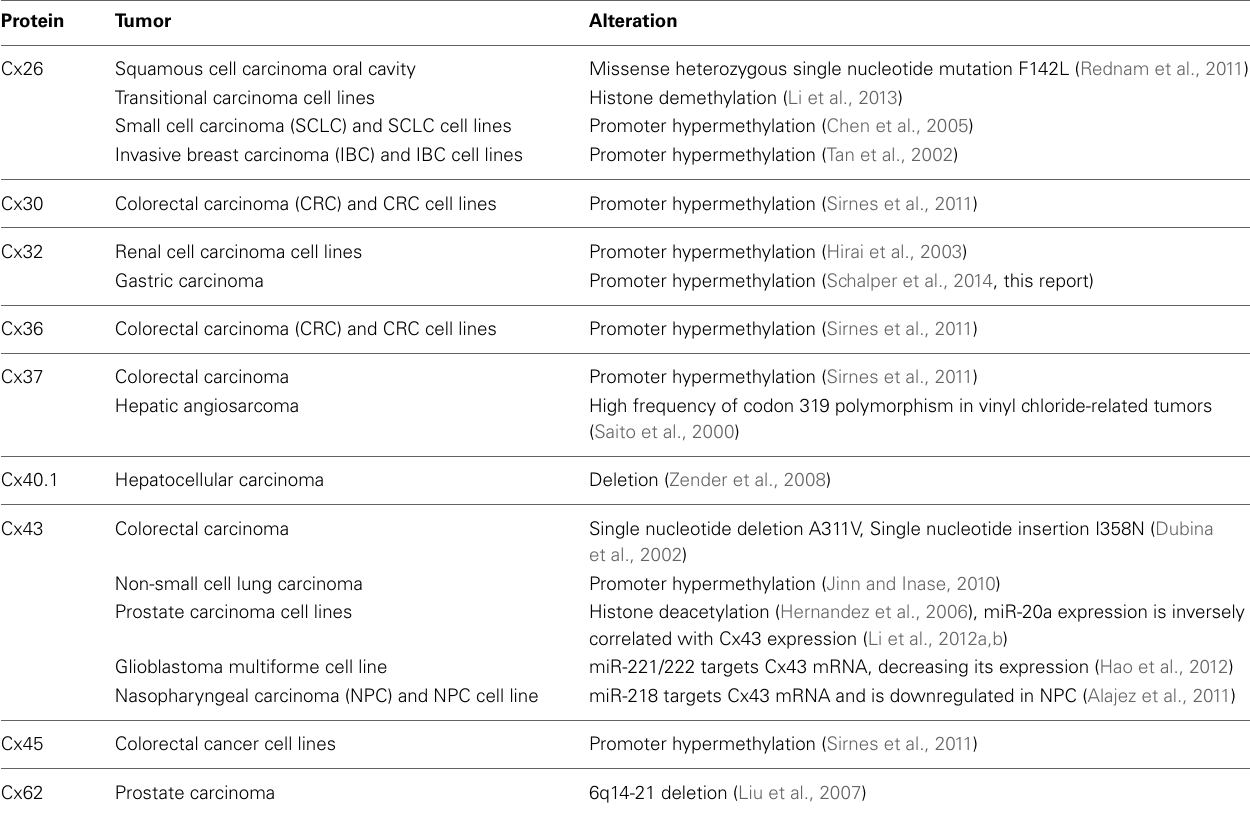
Table 1 | Possible mechanisms responsible for reduced expression of connexins in human cancers and cell lines.